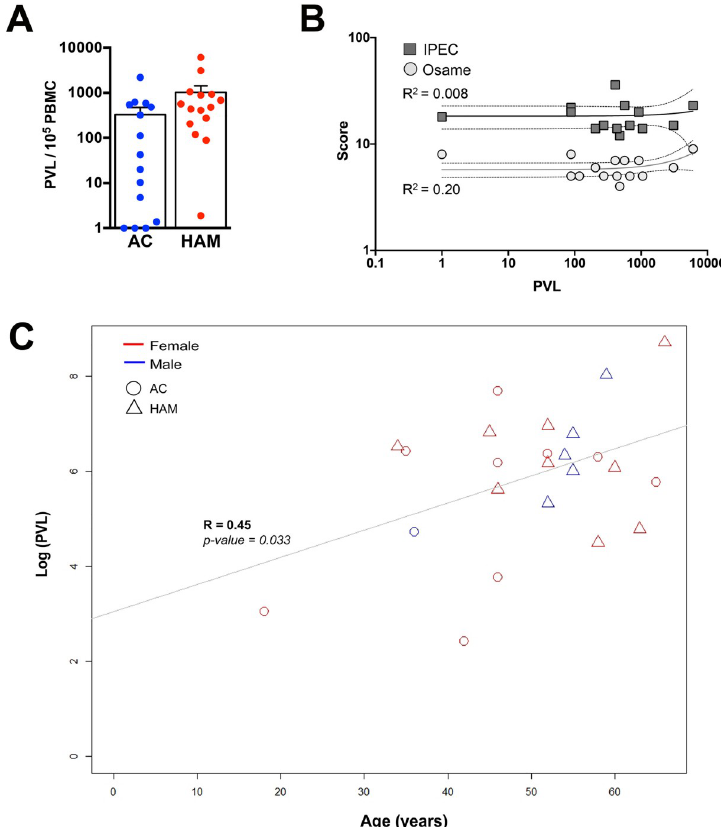
Fig 1. PVL in PBMCs does not correlate with the clinical status in HTLV-1 infected subjects. (A) Proviral load (PVL) of the HTLV-1 asymptomatic carriers (AC) and HAM/TSP patients. (B) Graph representing motor scores (IPEC and Osame) and PVL in HAM/TSP patients. (C) Correlation between PVL of HTLV-1-infected individuals and the age at the time of the analysis.